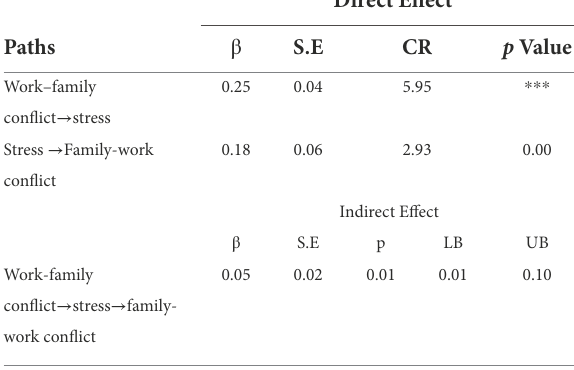
TABLE 4 Work to family conflict, stress, and family to work